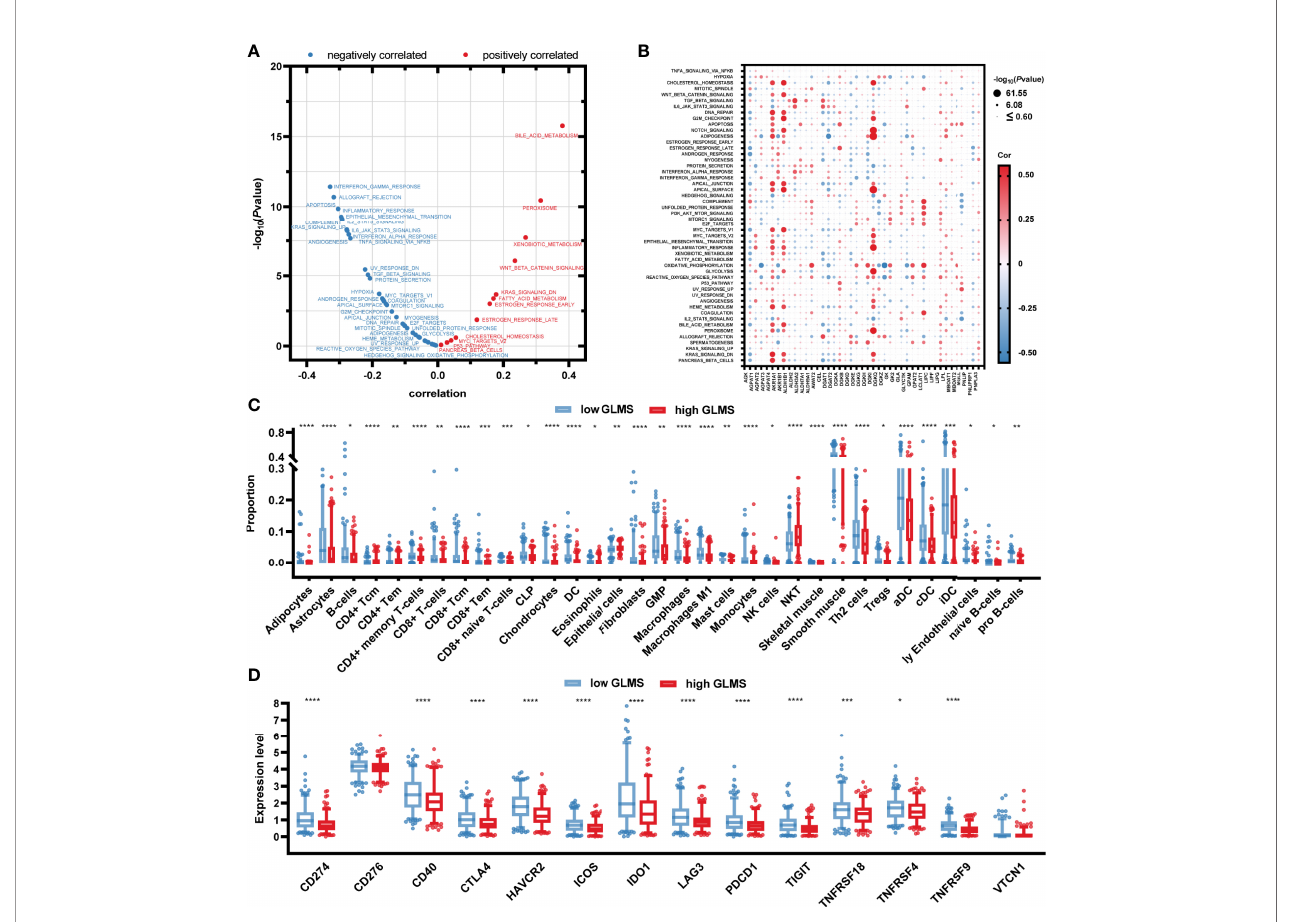
FIGURE 4 | Potential molecular mechanisms of glycerolipid metabolism. (A) Correlation between glycerolipid metabolism score (GLMS) and ssGSEA enrichment scores of 50 cancer hallmark pathways in TCGA-COAD cohort. (B) Correlation between the expression level of 42 glycerolipid metabolism-related genes and ssGSEA enrichment scores of 50 cancer hallmark pathways. (C) The abundance of each tumor microenvironment (TME)-in fi ltrating cell between high- and low- GLMS groups in TCGA-COAD cohort. (D) The difference of 14-immune checkpoint mRNA expression between high- and low-GLMS groups in TCGA-COAD cohort. *P < 0.05, **P < 0.01, ***P < 0.001 and ****P < 0.0001 by the Mann – Whitney